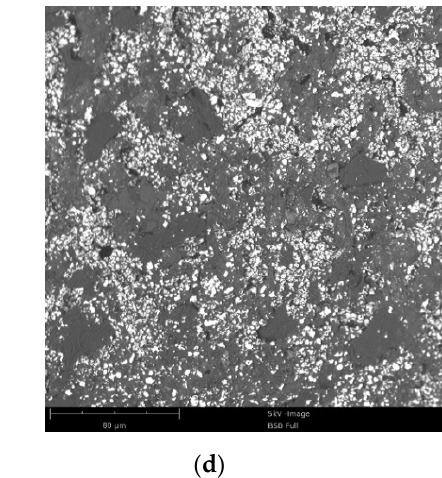
Figure 2. Microstructures of RMs specimens: ( a ) 26.5% Al/73.5% PTFE; ( b ) 5.29% Al/80% W/14.71% PTFE; ( c ) 62% Hf/38% THV; ( d ) 88% Hf/12% THV.